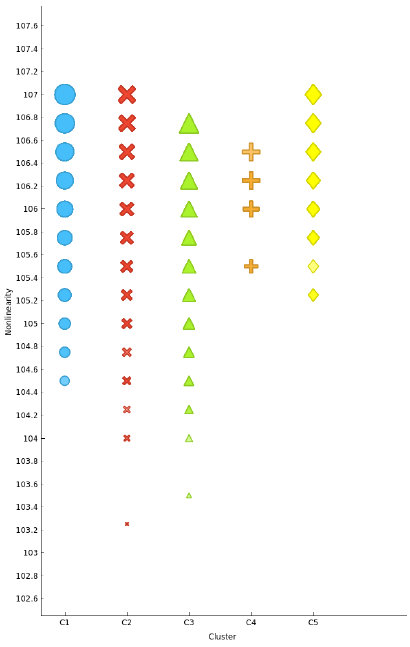
Figure 8. SFS clusters of